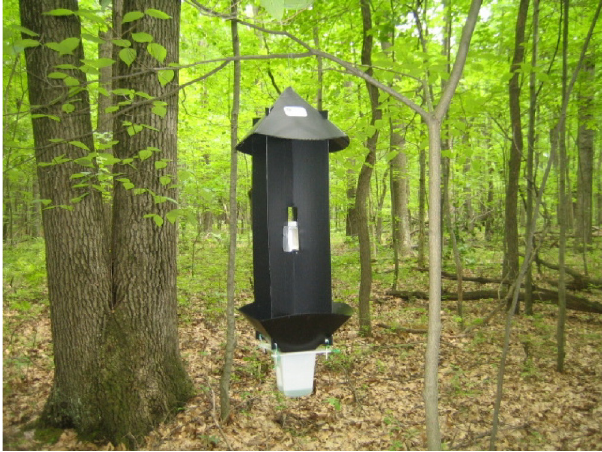
Figure 1. Intercept Panel trap used for capturing Cerambycid beetles.